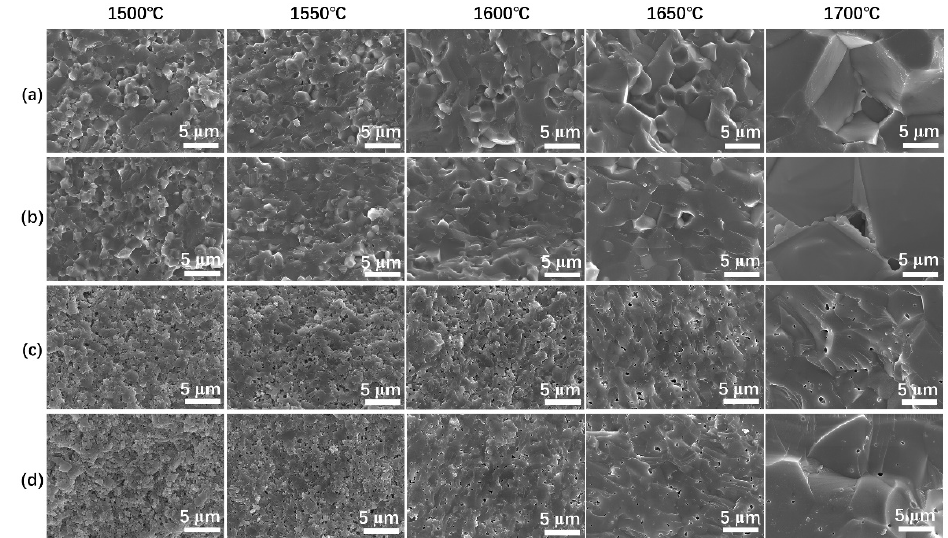
Figure 3. SEM of the fracture surfaces of the ceramics sintered under different temperatures: ( a ) AlN–Al 2 O 3 –0.5% Y 2 O 3 ; ( b ) AlN–Al 2 O 3 –1.0% Y 2 O 3 ; ( c ) AlN–Al 2 O 3 –10% LiAl 5 O 8 and ( d ) AlN–Al 2 O 3 – 20% LiAl 5 O 8